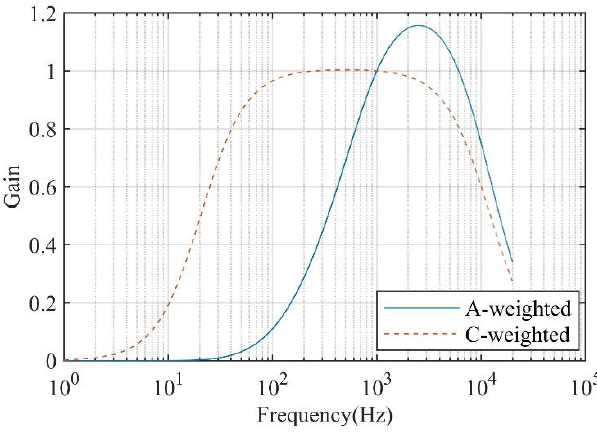
Figure 3. Gain curves of A-weighting and C-weighting.